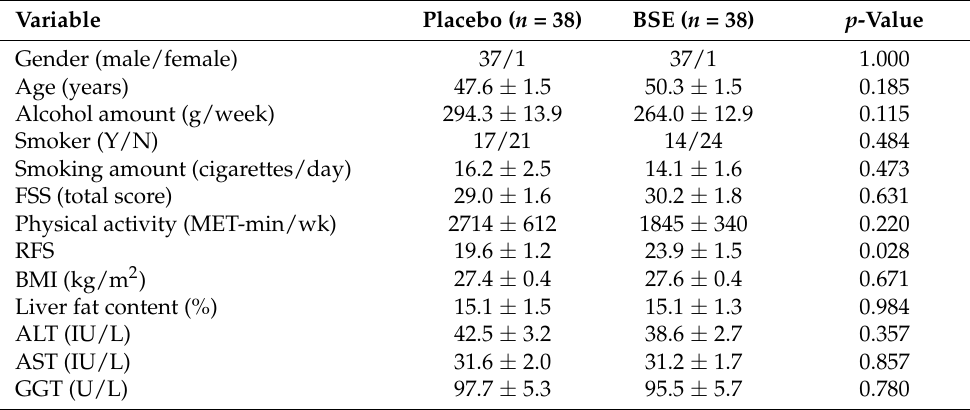
Table 1. Baseline characteristics of the ITT subjects who participated in this